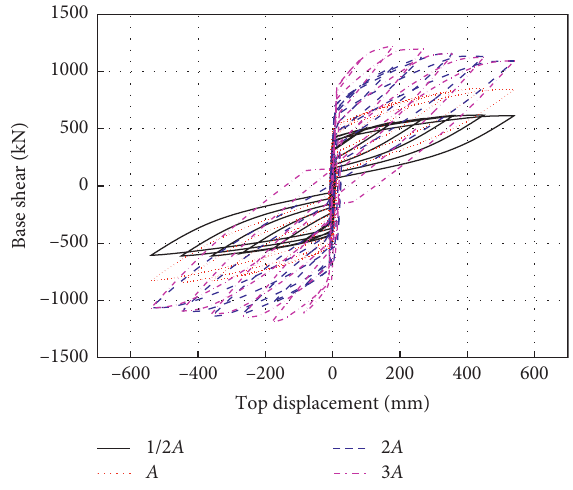
Figure 29: Hysteresis loop of base shear versus top displacement.